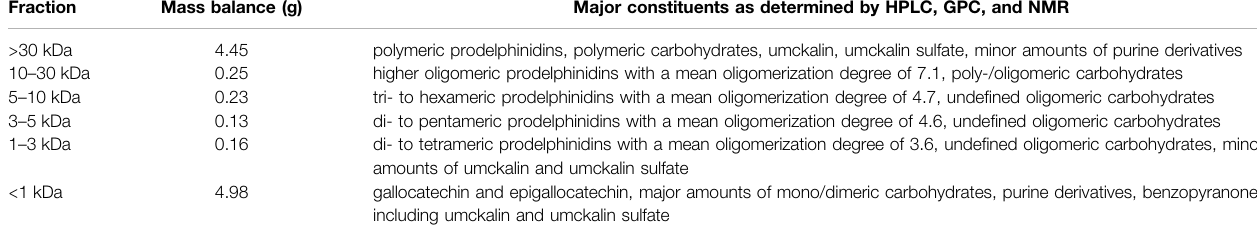
TABLE 2 | Phytochemical characterization of EPs 7630 fractions. Fraction Mass balance (g) Major constituents as determined by HPLC, GPC, and NMR > 30